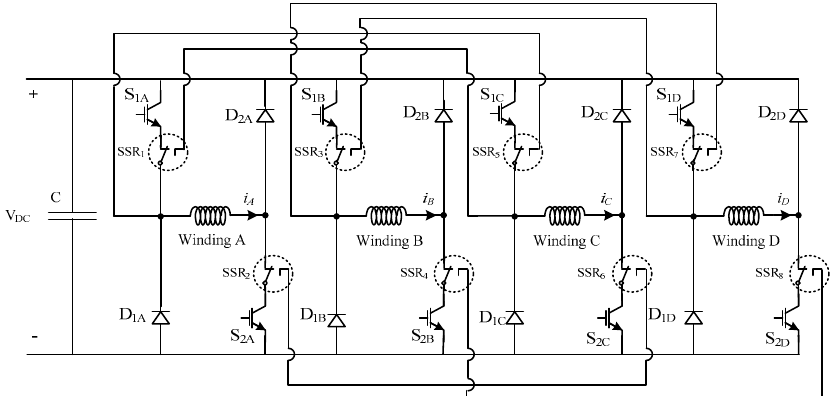
Figure 26. Fault-tolerant topology proposed by [91] using a healthy leg to control two phases not in sequence. This solution requires several solid-state relays (SSRs) to connect the faulty legs to other healthy phase in order to replace and isolate the faulty power semiconductors.